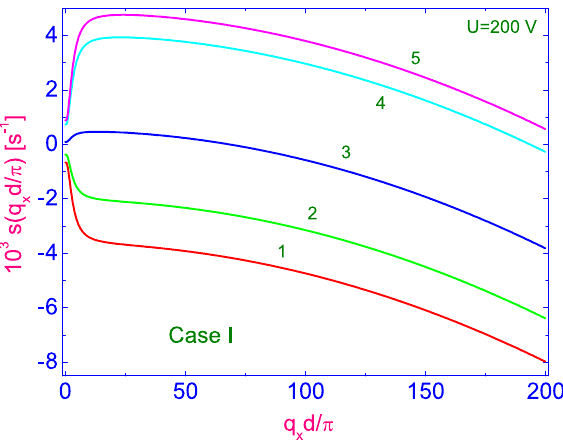
Figure 6. Plot of the growth rate s ( q x d / π ) in s − 1 vs. dimensionless wavelength q x d / π under the effect of the voltage U = 200 V, calculated for a number of values of the angle α [11], same as in Figure 5.